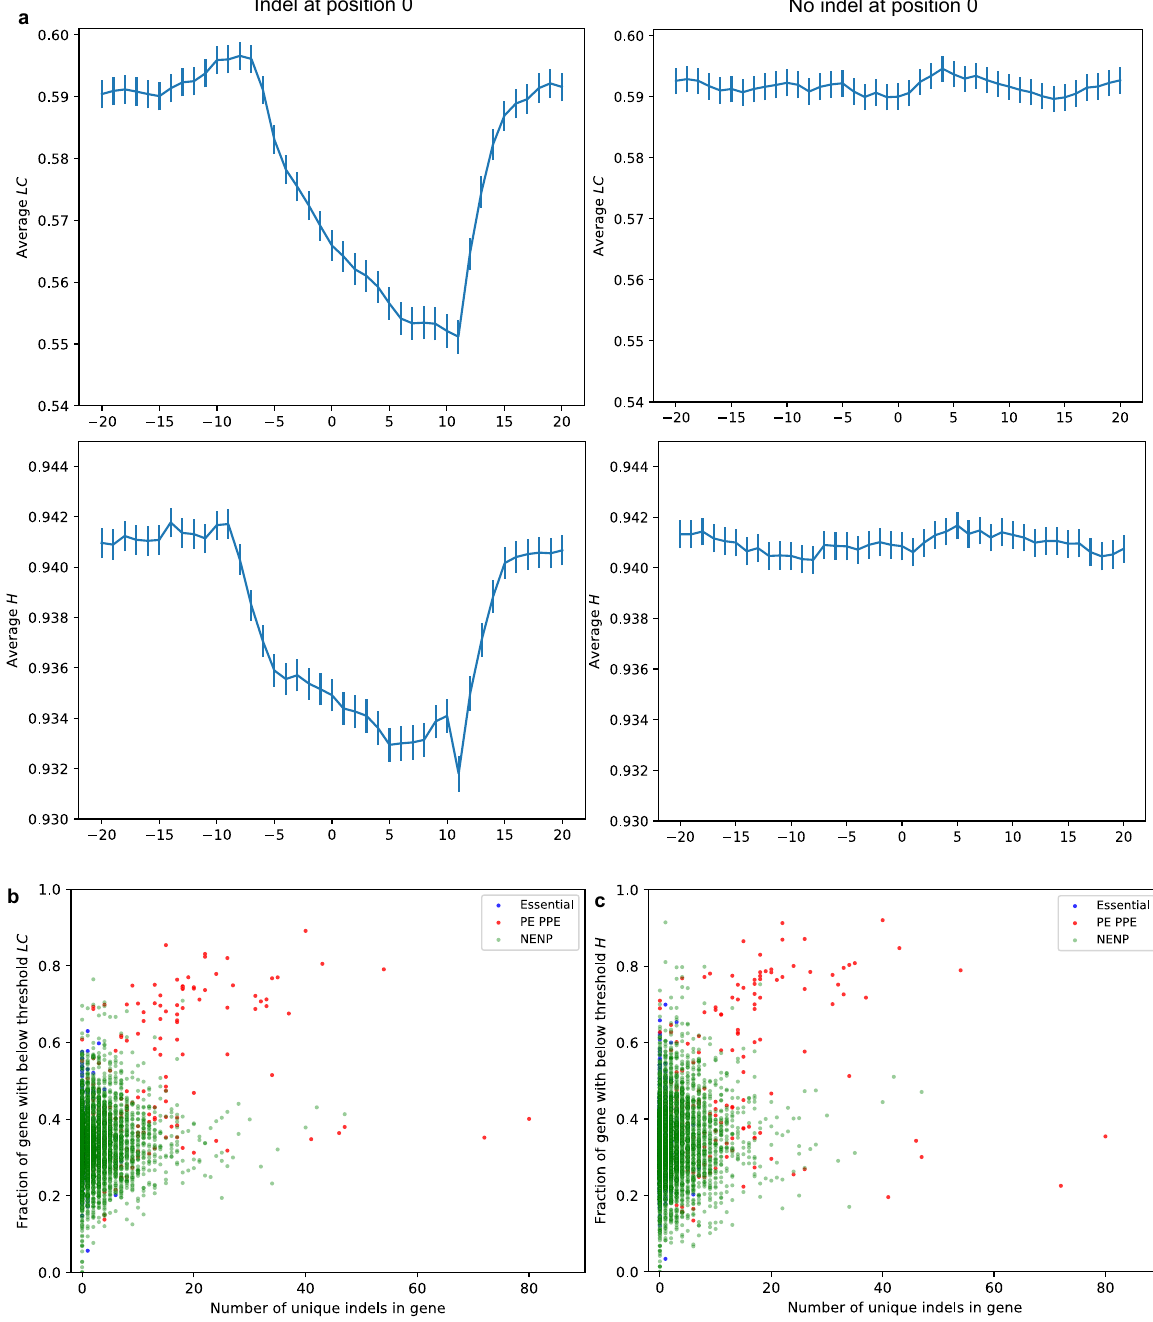
Fig. 2 Relationship between the frequency of indel occurrence and sequence complexity in the M. tuberculosis genome. a The linguistic complexity ( LC ) and Shannon ’ s entropy ( H ) scores are shown for 20 positions upstream and downstream of orphan indels that do not have another indel within 100 bases ( n = 5172), and randomly sampled non-indel sites that do not have an indel within 100 bases of the site ( n = 5775). The sequence complexity pro fi le in the vicinity of the indel and non-indel sites are different. The average LC and H scores adjacent to the indel sites show a decrease in the complexity scores 7 – 10 bases before the indel position (indicated by 0 on the x -axis) and 15 – 18 bases after the indel position. The error bars represent ±1 SEM (standard error of the mean). See Fig. S3 for density distributions of LC and H scores at and around these indel and non-indel positions. b The fraction of each gene that has a complexity score below the threshold score for LC , and c the fraction of each gene that has a complexity score below the threshold score for H in essential (blue), PE-PPE (red), and the remaining genes that are neither essential nor PE-PPE (NENP, faded green). The threshold scores ( H = 0.932, LC = 0.551) are the lowest H/LC scores in the indel pockets shown in Fig. complexity regions in the PE-PPE genes likely contributes to the high indel incidence in these genes (and possibly high indel error rate compared to high complexity regions), but indels may be restricted in non-PPE genes by negative selection.